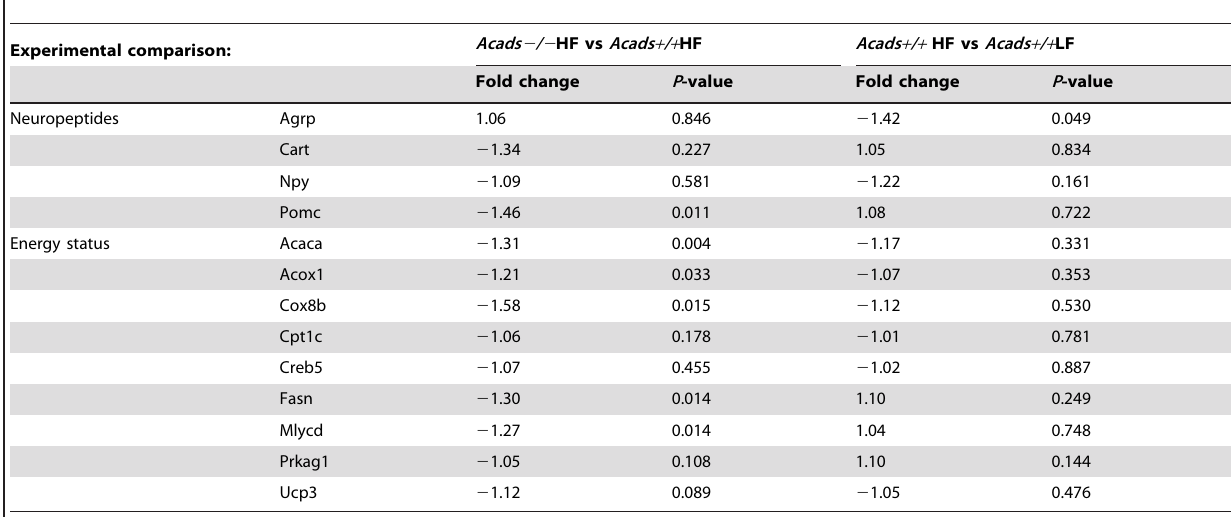
Experimental comparison: